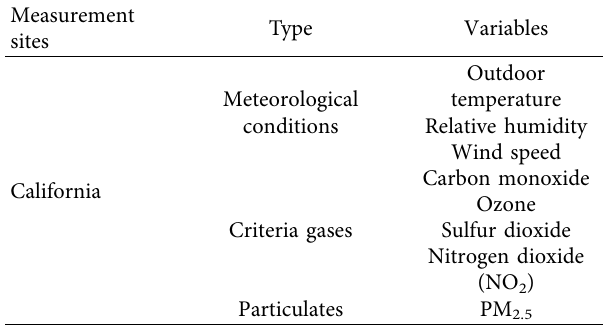
Table 1: Summary of measurement sites and observed